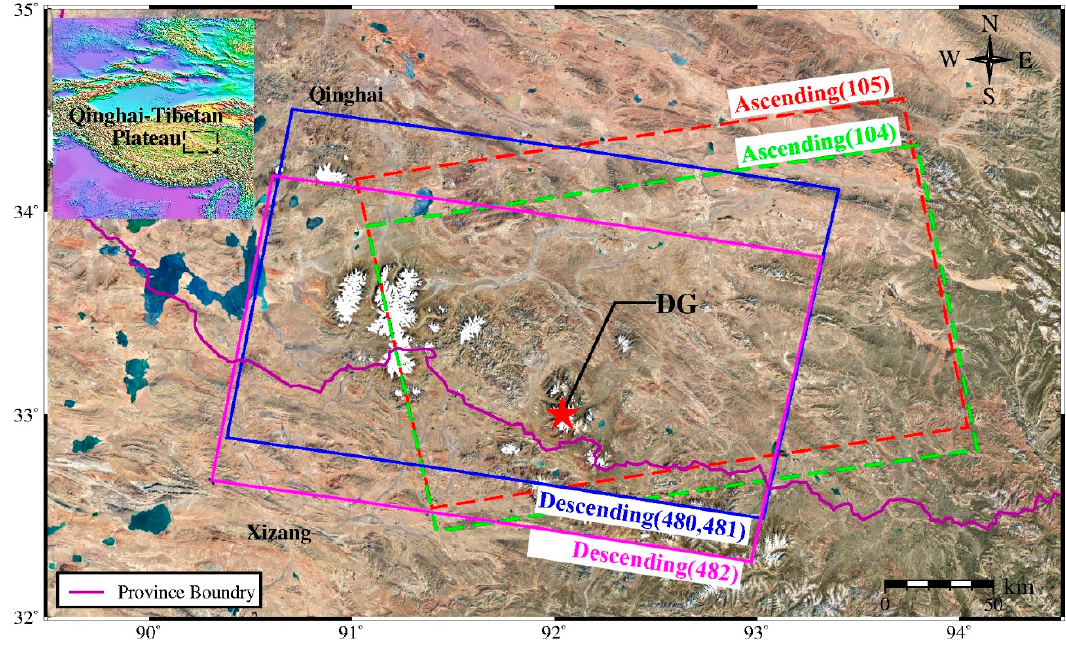
Figure 1. The study area and the coverage of the Sentinel-1A SAR images collected along the ascending and descending orbits. The red pentangle shows the location of the Dongkemadi Glacier (DG). The inset in the upper-left corner shows the relative geographical location of the study area (marked by the dashed rectangle) in the Qinghai-Tibetan Plateau (QTP).